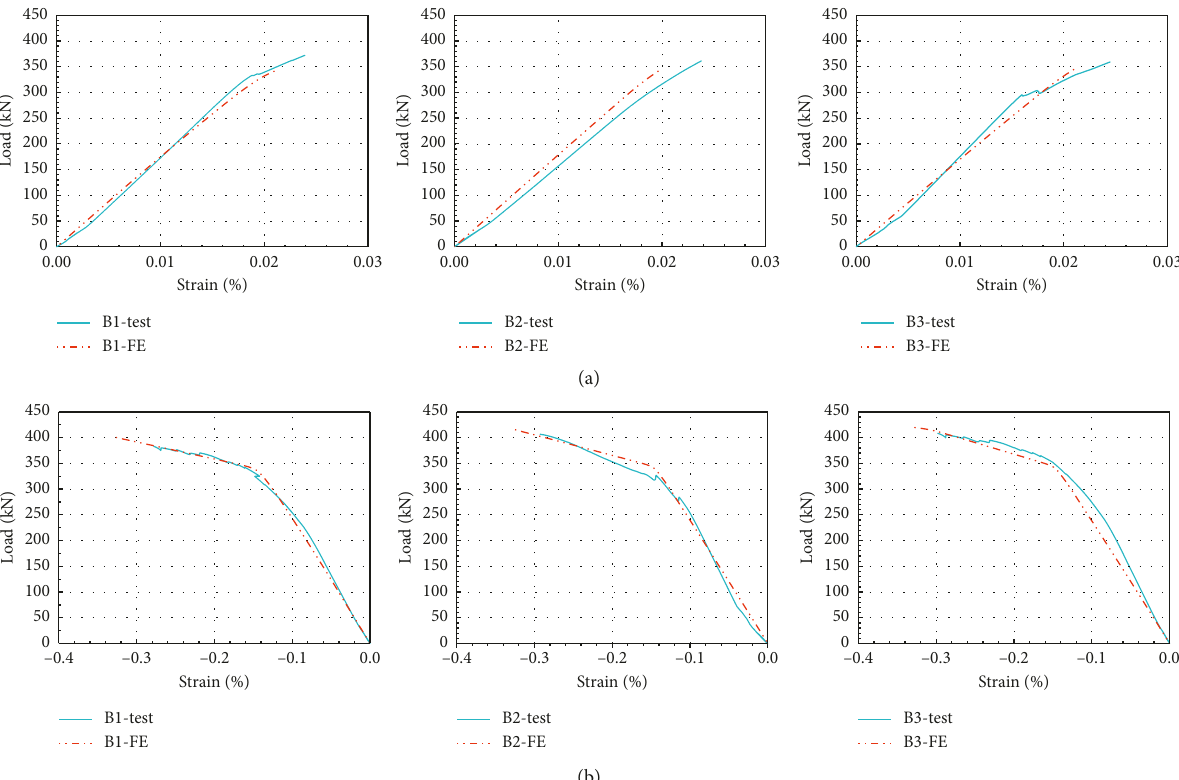
Figure 16: Comparison of the load-strain curves from the test and FE analysis. (a) Bottom chord at midspan. (b) Concrete slab at